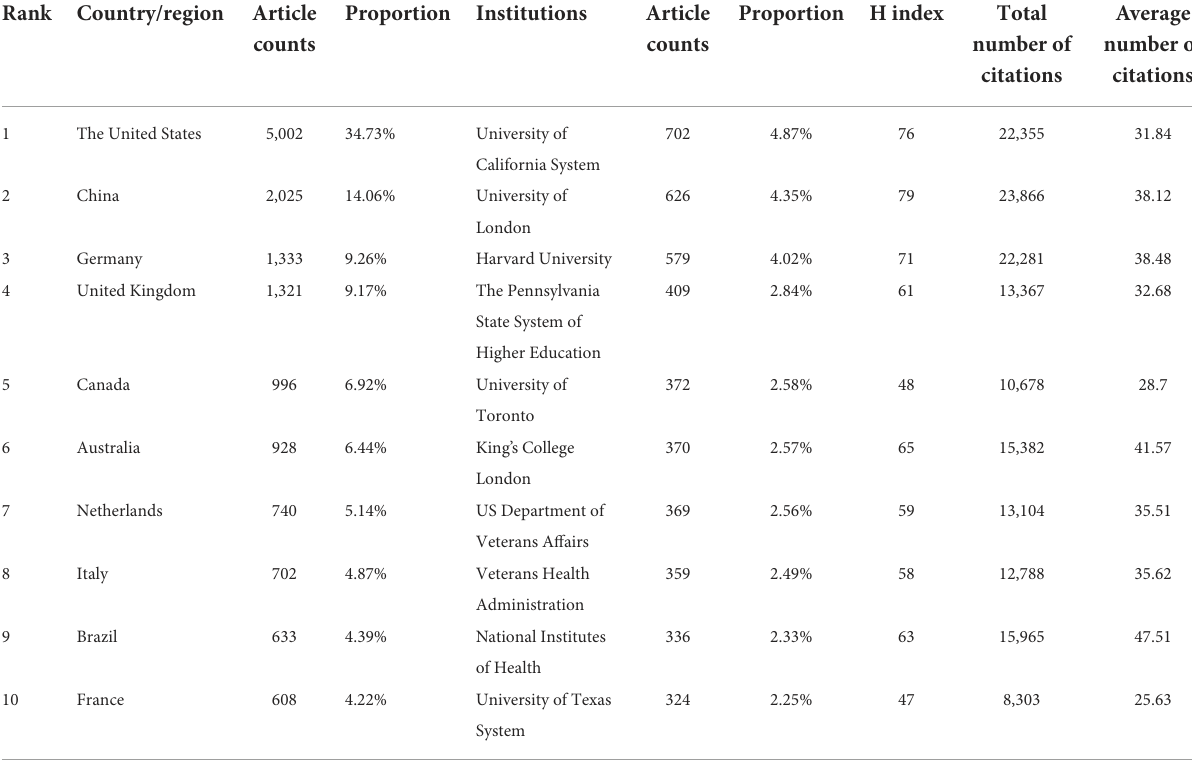
TABLE 1 The main countries, regions, and institutions contributing to publications in depression biomarker research. Rank Country/region